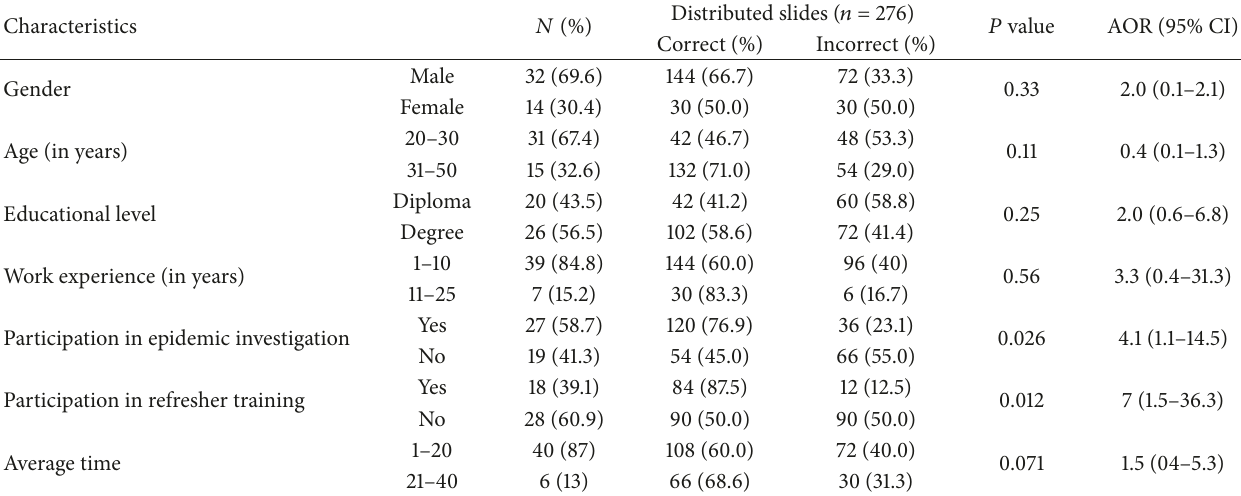
Table 4: Multivariate analysis of malaria diagnosis using light microscopy in Tigray, North Ethiopia, 2016.